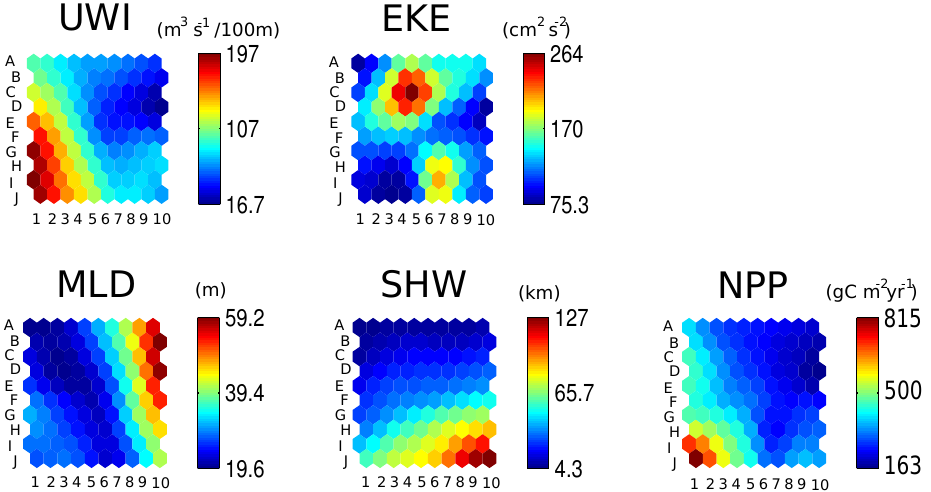
Fig. 5. Component planes of the SOM. Each plane shows the distribution of one variable across the map.